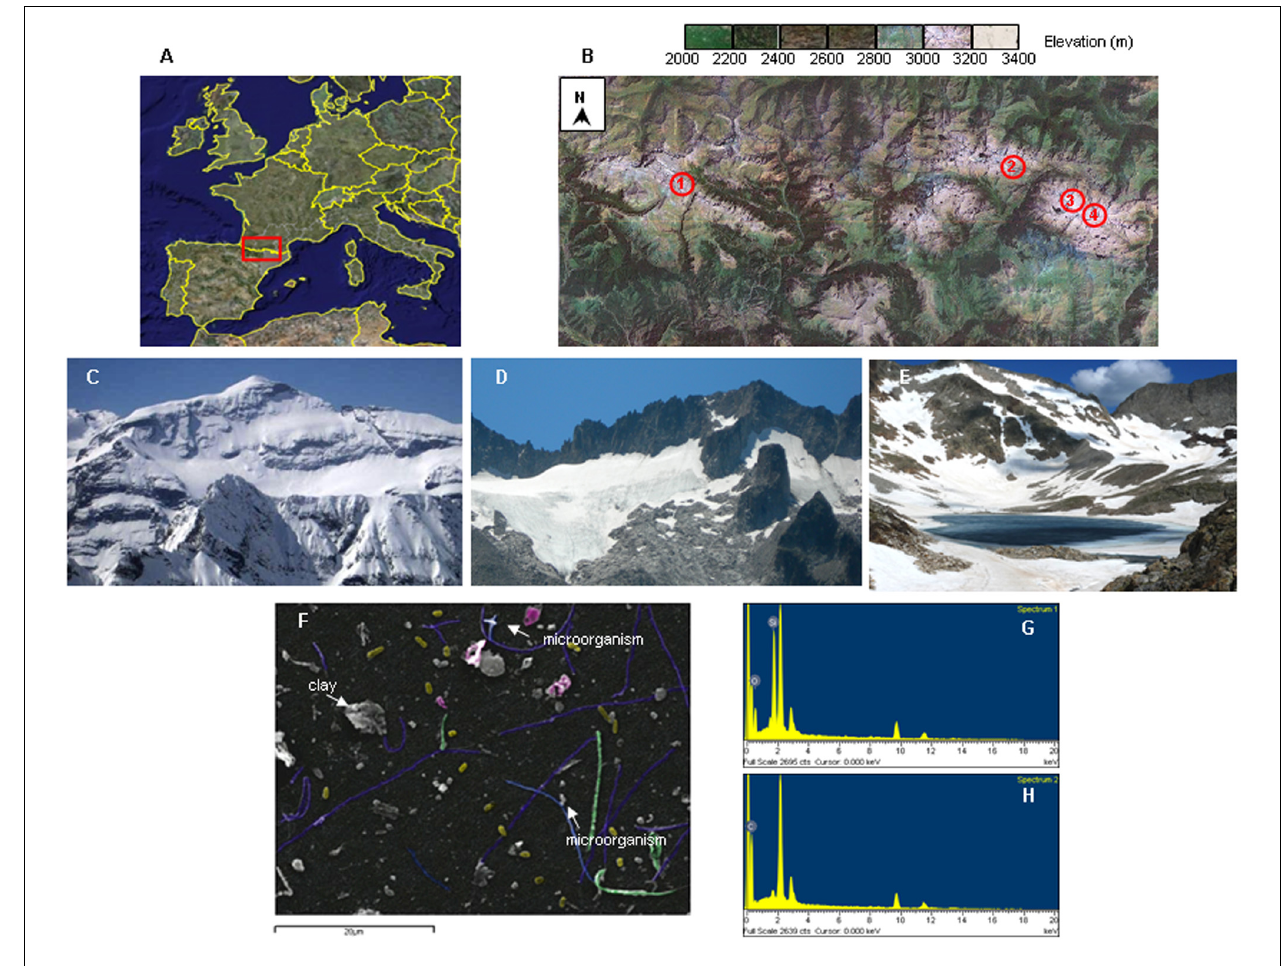
image of microorganisms in a matrix of fine sediment particles from LIT ice meltwater illustrating their morphology compared with glacial till. (G,H) Representative energy-dispersive X-ray analysis spectra from microorganisms collected at Pyrenean glaciers. Full vertical scales in counts per second are variable according to the area analyzed. Horizontal spectral ranges are in